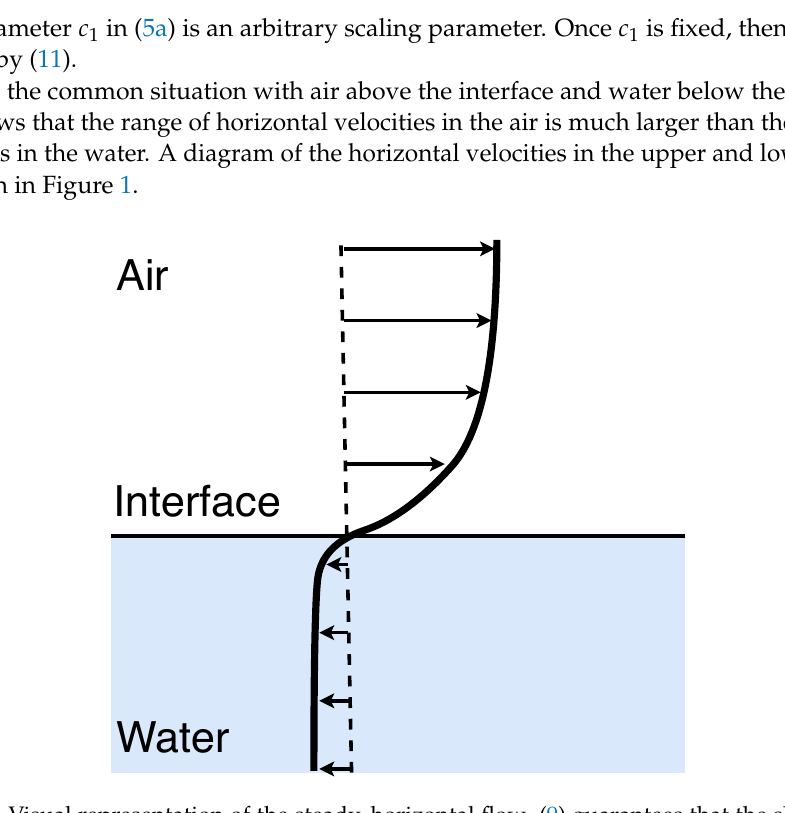
Figure 1. Visual representation of the steady, horizontal flow. (9) guarantees that the shear stress across the interface is continuous. Using (10) and (11) we can see that the ratio of upper to lower velocity is given by c 3 . Typically, this ratio is in the range of 0.003–0.004. (Note: Figure not to scale. c 1 In reality, the lower arrows would be much